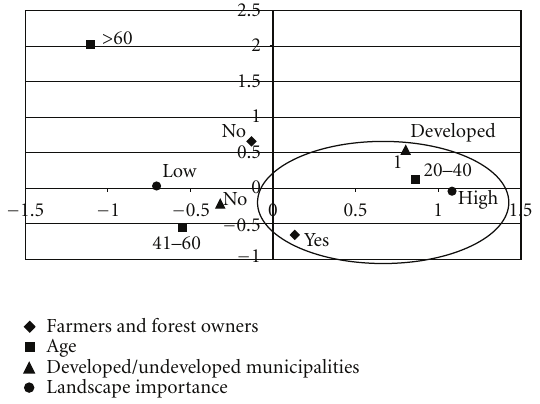
Figure 6: Multiple correspondence analysis for “landscape impor- tance.”